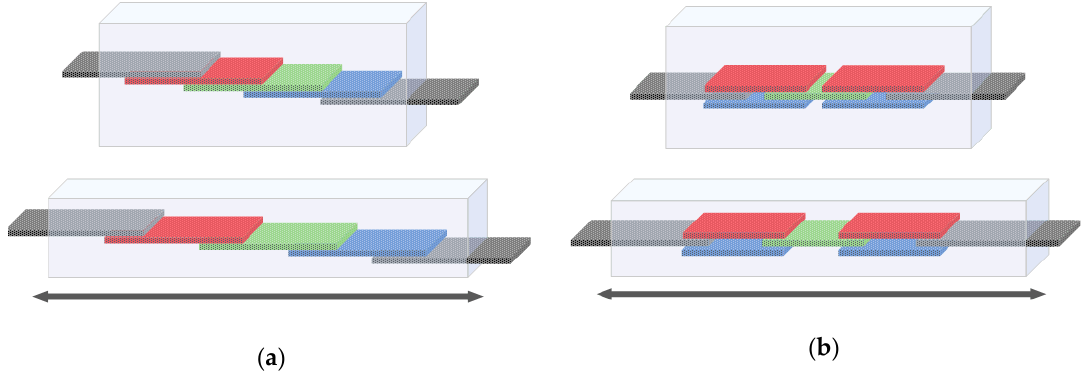
Figure A1. Colors are shown for visual effect; ( a ) descending layer fabric pattern in the standard and extended length; ( b ) triple layer fabric pattern in the standard and extended length.